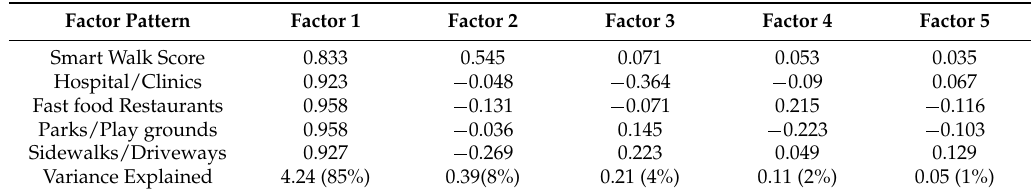
Table 3. Factor analysis for cardiovascular